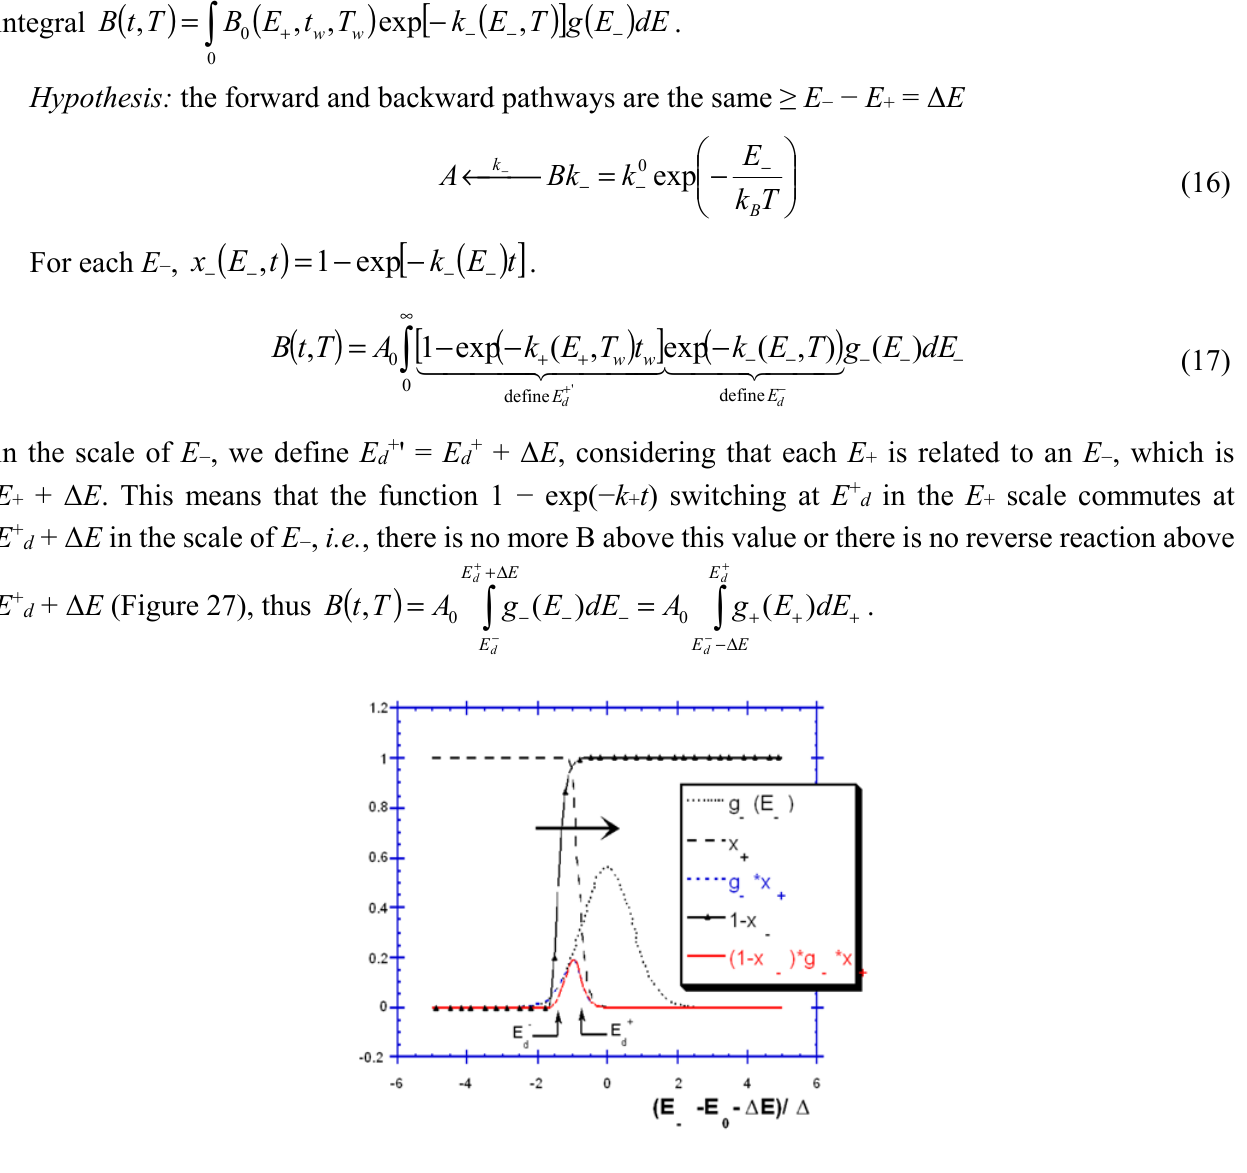
Figure 27. Erasure of incomplete